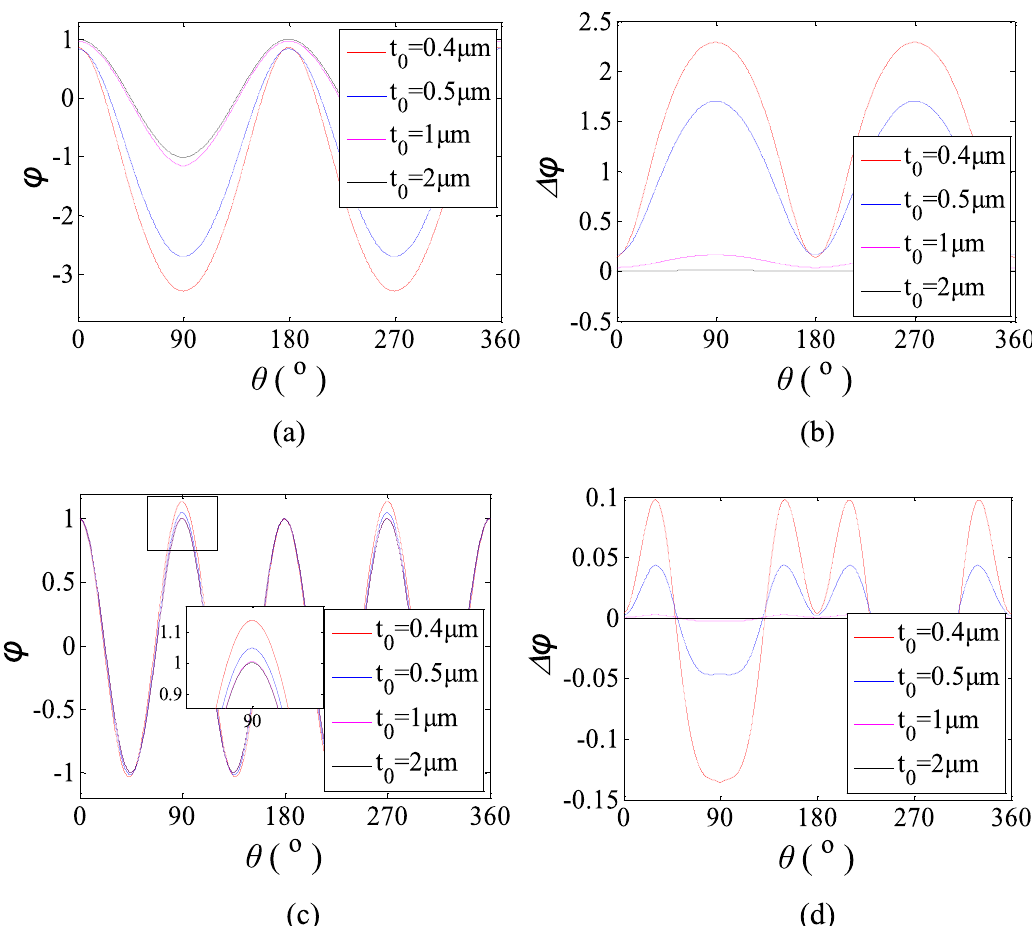
Fig. 4. Vibration modes for different clearance t 0 . (a) Mode 1 (b) D f = f e (cid:1) f 3 for mode 1 (c) mode 2 (d) D f = f e (cid:1) f 3 for mode